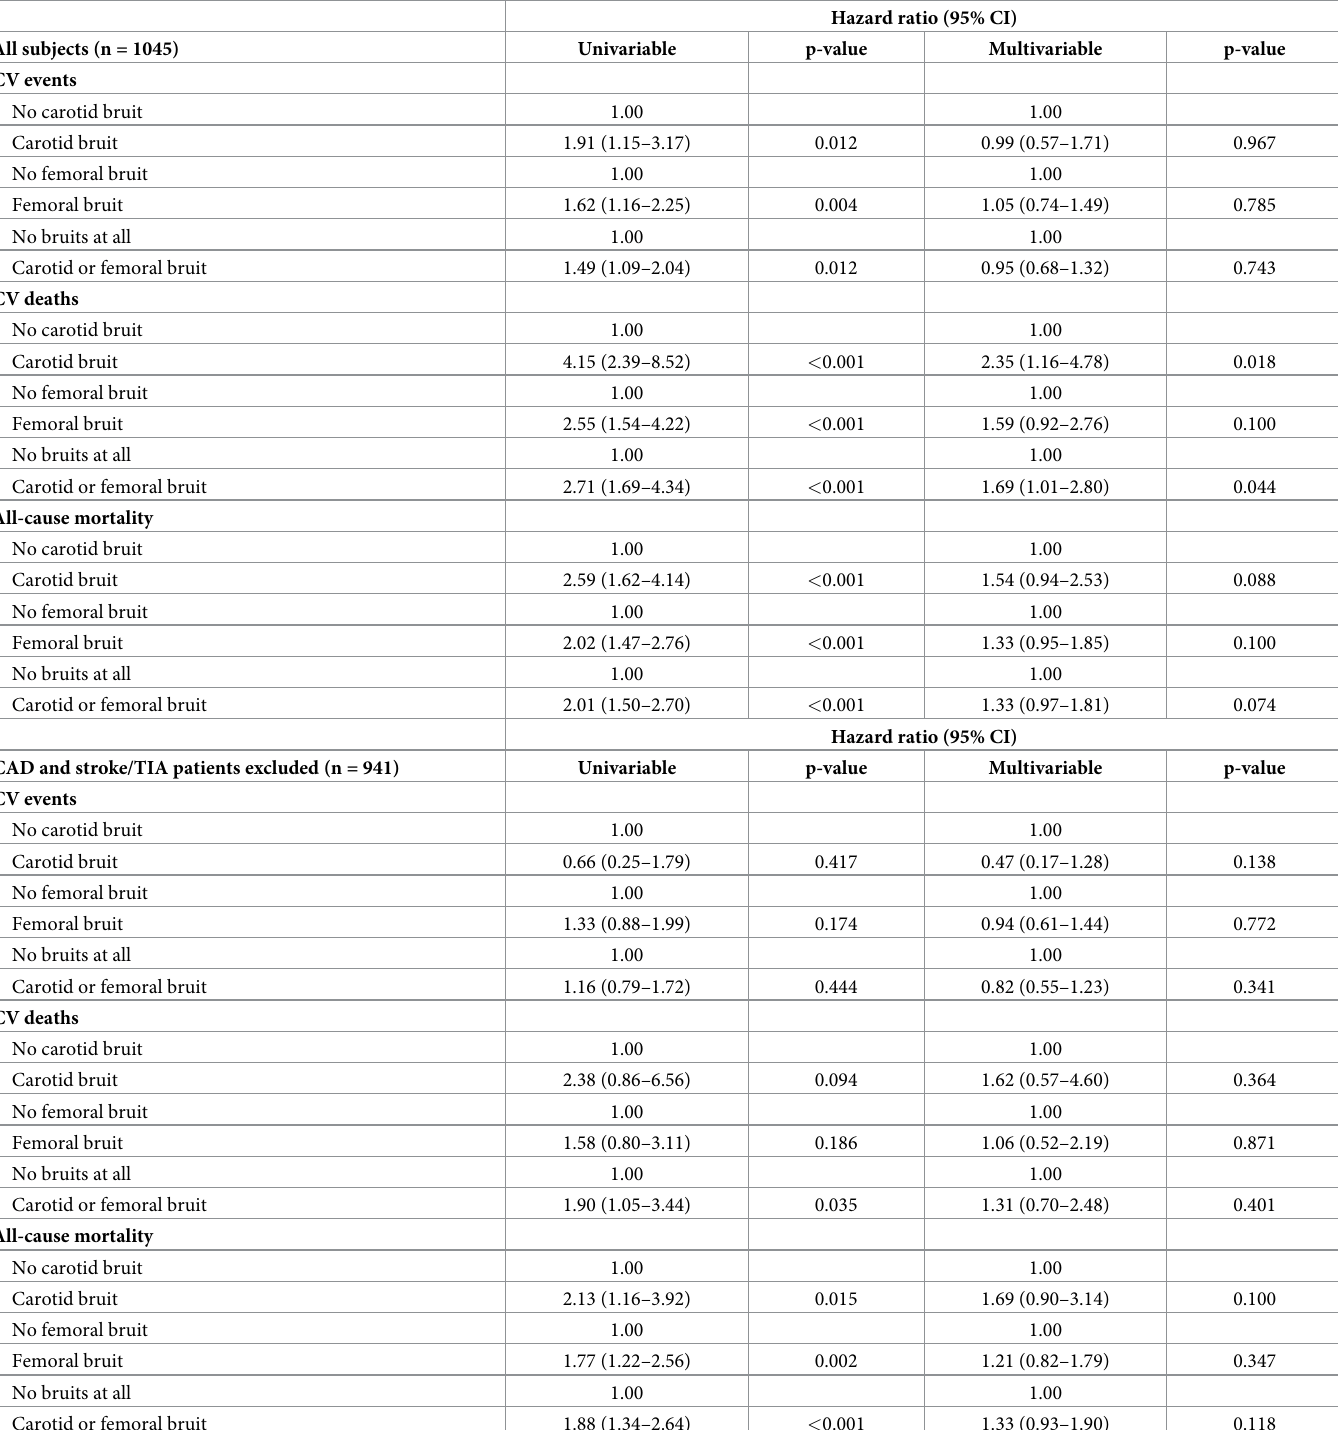
Table 2. Hazard ratios of arterial bruits in predicting cardiovascular deaths and all-cause